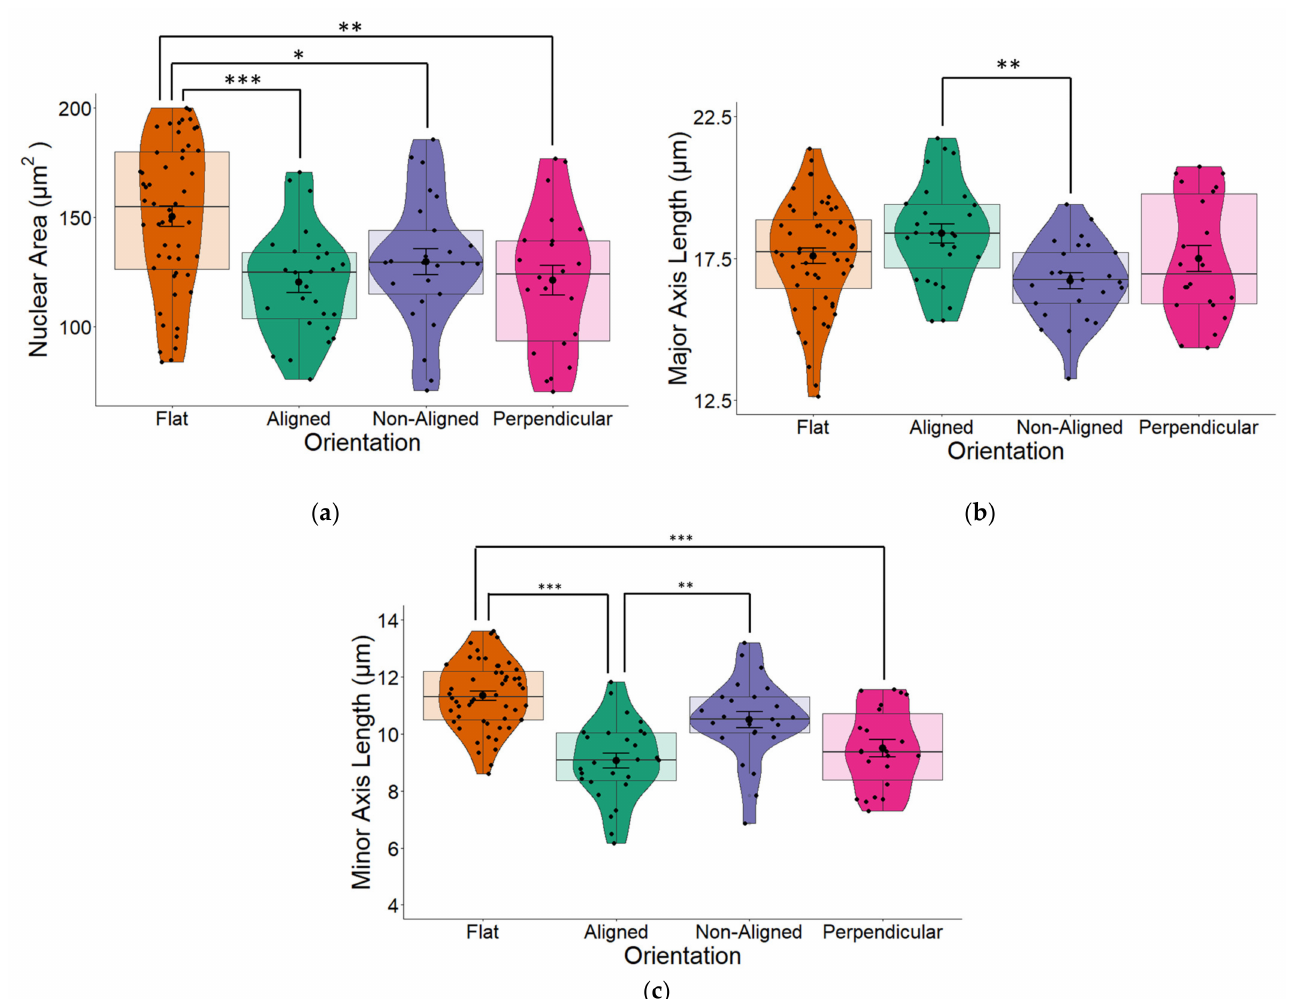
Figure 12. ( a ) The nuclear area of human SH-SY5Y cells grown on aligned or non-aligned scaffolds following ES. To determine whether ES had an additive effect on nuclear morphology, the cells were stimulated for 3 h using a 100 mV/mm direct current (DC) EF. The surface area of the nucleus was measured 17 h following stimulation and was found to be significantly altered (one-way ANOVA p < 0.001). Cells grown on aligned ( p < 0.001) and non-aligned ( p = 0.040) scaffolds had significantly reduced surface area compared to cells grown on the plain glass coverslips. Additionally, we also discovered that cells that were growing in the plane perpendicular to the electrical field also displayed smaller nuclear surface areas ( p = 0.002) compared to cells growing on the glass coverslips. ( b ) Quantification of nuclear length along the major (long) axis of SH-SY5Y cells following ES. Stimulation of SH-SY5Y cells with a 100 mV/mm direct current for 3 h led to overall changes in nuclear morphology (One-way ANOVA p = 0.020). The length of the major axis of cells growing on aligned scaffolds was significantly different ( p = 0.009) compared to cells growing on non-aligned scaffolds. ( c ) Quantification of nuclear length along the minor (short) axis of SH-SY5Y cells following ES. The most profound changes following ES were observed along the minor axes of cells growing on scaffolds. The minor axis of cells growing on aligned scaffolds showed the largest and most significant decreases compared to both control ( p < 0.001) and non-aligned ( p = 0.001) scaffolds. Decreases were also observed between perpendicular and flat controls. * p < 0.05, ** p < 0.01, *** p < 0.001. Flat n = 52, aligned n = 27, non-aligned n = 25, perpendicular n =